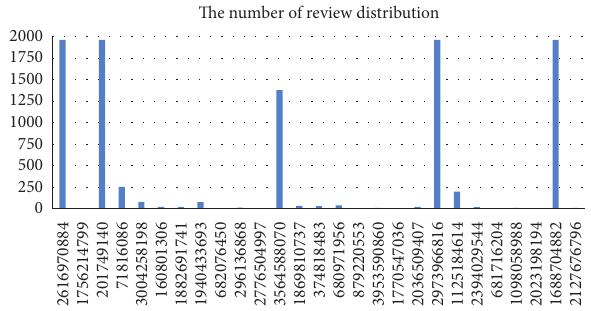
Figure 1: Distribution of the reviews per